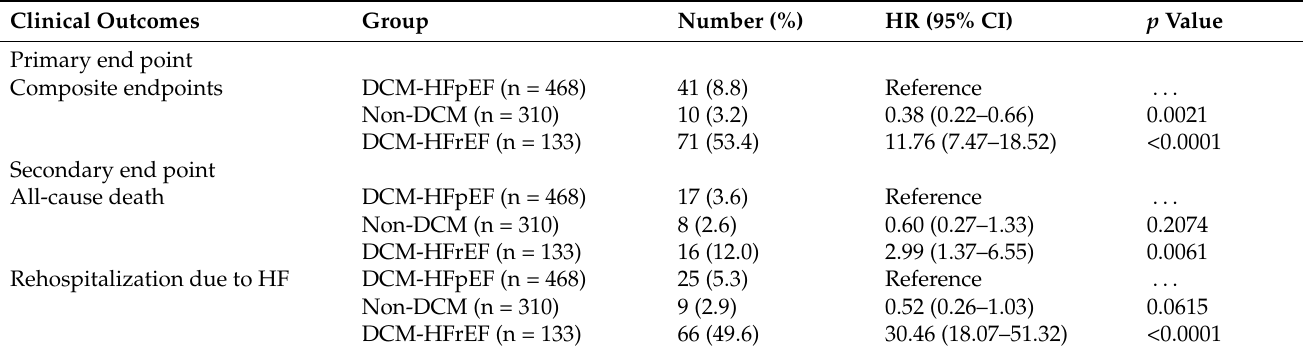
Table 2. Clinical outcomes at 45.5 months.